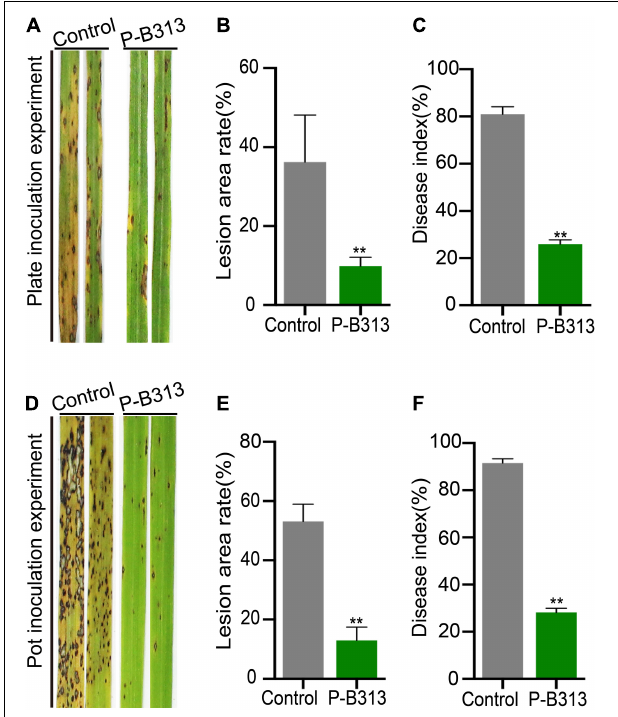
FIGURE 6 | Effect of P. oryzae on resistance against rice blast. (A,D) The severity of devastating symptoms on the leaves of P. oryzae -inoculated rice compared to control in plate and pot experiments, respectively. (B,E) An AxioVision image analyzer evaluated the lesion area. Bar charts were plotted with Mean ± SD. (C,F) According to the disease classification, the disease index of P. oryzae -infected and control-infected rice was calculated. Bar charts were plotted with Mean ± SD from 30 plants, respectively. Independent-samples t -test analyzed data. The symbols * and ** indicate significant differences at P < 0.05 and P < 0.01,